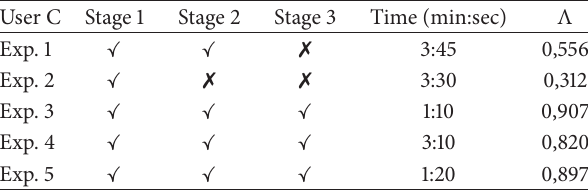
Table 3: Results of the experiment. User C.